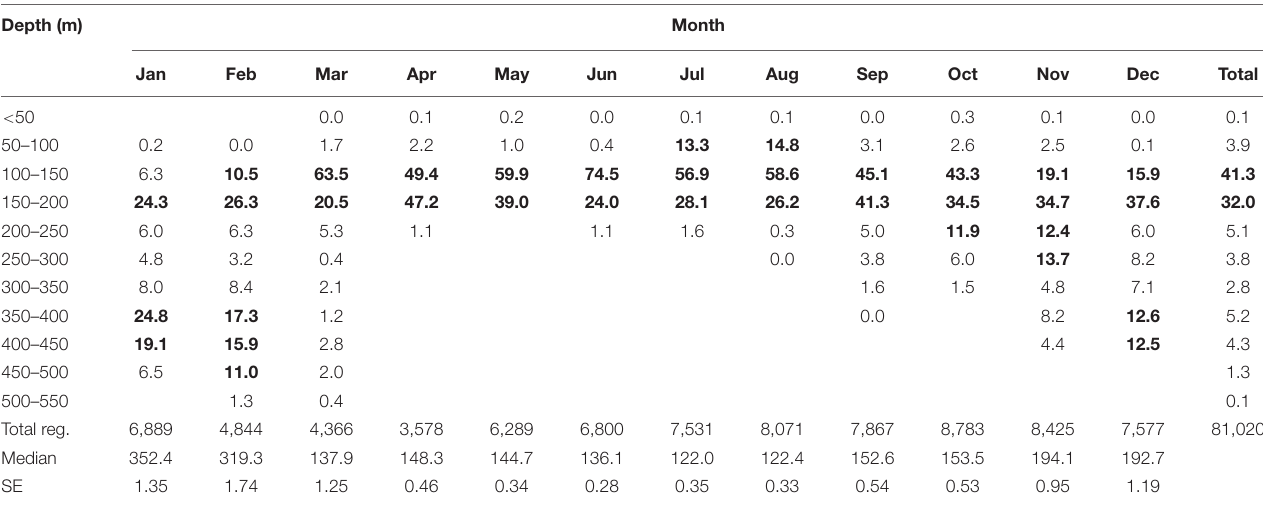
TABLE 3 | Depth registrations once per hour as percentages of total registrations per